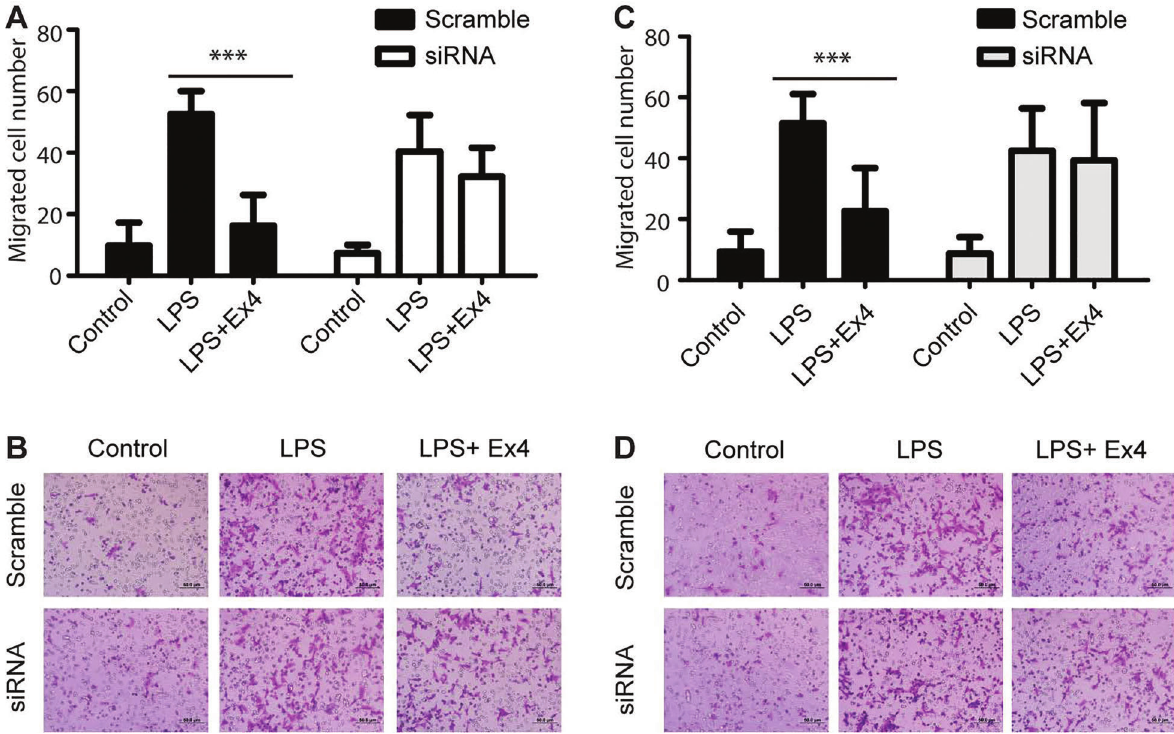
Figure 2. Effect of exendin-4 (Ex4) on the migration of macrophages and corresponding photomicrographs (bar: 50 m m). RAW264 cells ( A and B ) or mouse peritoneal macrophages ( C and D ) were treated with lipopolysaccharide (LPS) or a combination of LPS and exendin-4, and then transwell migration was performed for 24 h. Data are reported as means ± SD. ***P o 0.001